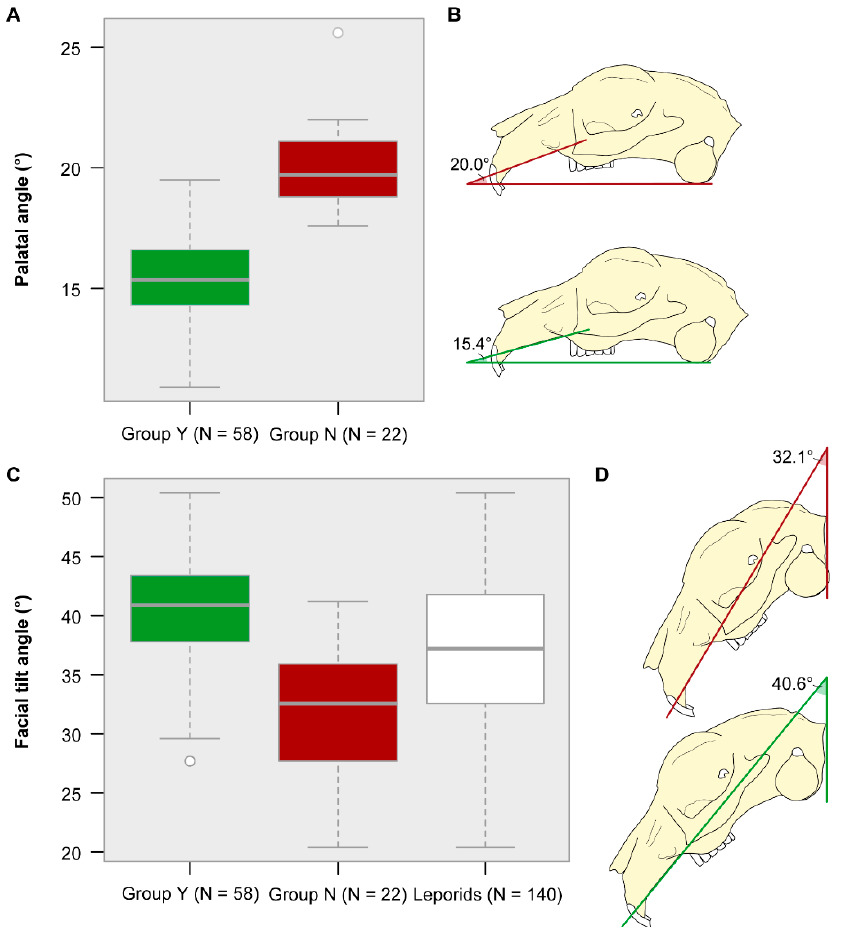
Figure 4. Variance in palatal angle and facial tilt angle. ( A, C ) Boxplot and ( B, D ) schematic visualization of the mean angle for each group. Both, the palatal angle and the facial tilt angle, are significantly different between group Y and group N. ( C ) The variance in facial tilt angle among leporids (data from Kraatz et al. [23]) lies within the combined variance observed in pet rabbits (this study).